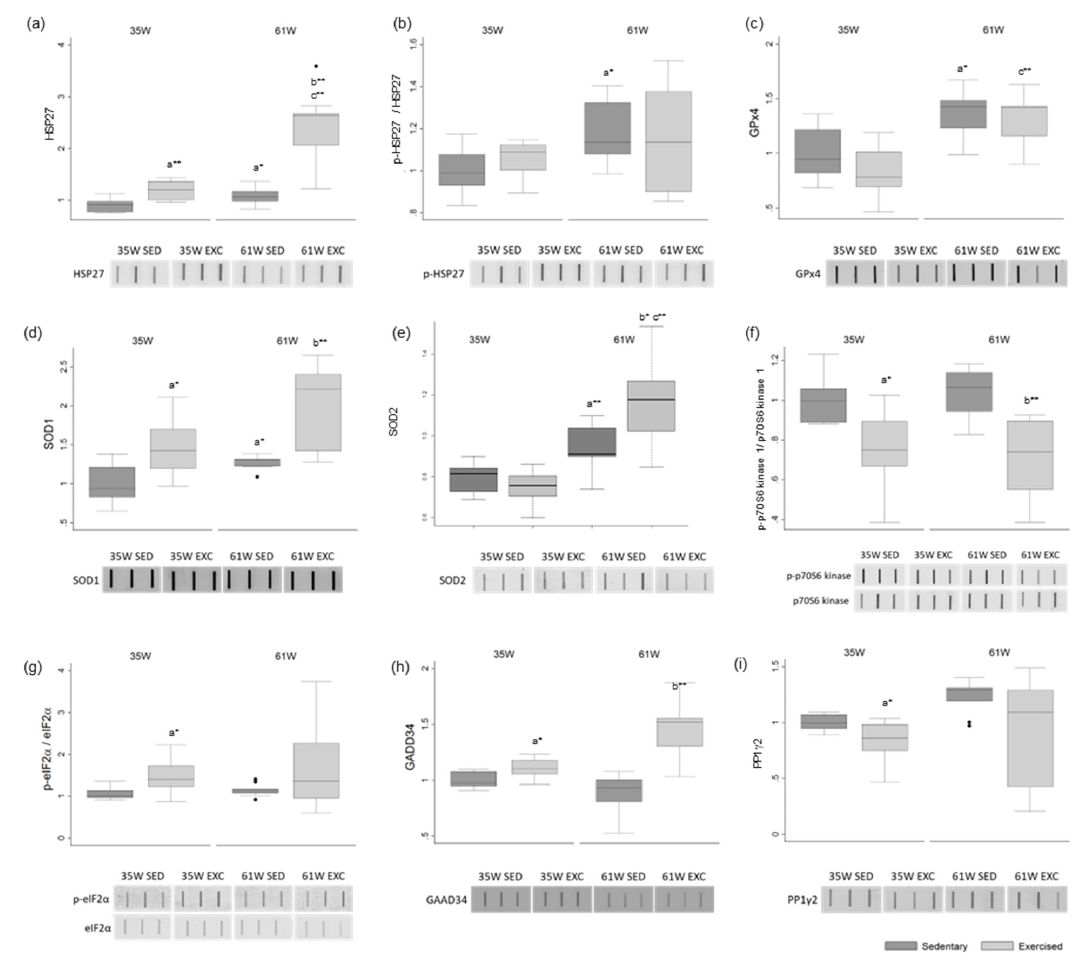
Figure 3. Box and whisker plots show the effect of exercise training and age on the protein levels of ( a ) HSP27, ( b ) p-HSP27, ( c ) GPx4, ( d ) SOD1, ( e ) SOD2, ( f ) p-RPS6KB1, ( g ) p-eIF2a, ( h ) GADD34